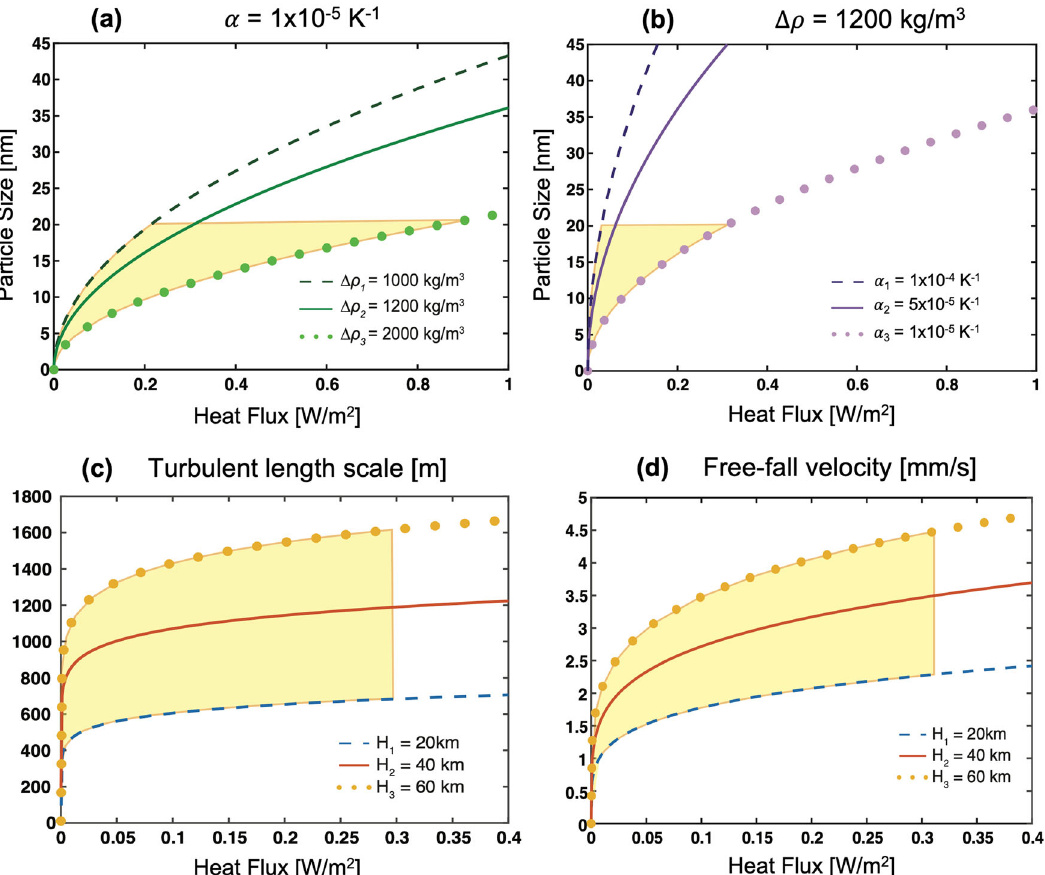
Fig. 3 Particle size, length scale, and velocity results. a Entrained particle size versus heat fl ux for three different fl uid-particle density contrasts of Δ ρ = 1000, 1200, and 2000kg m − 3 (corresponding to amorphous silica particle densities of 2000, 2200, and 3000 kg m − 3 , respectively) with a constant thermal expansion coef fi cient of α ’ 1 × 10 − 5 K − 1 . b Entrained particle size versus heat fl ux for thermal expansion coef fi cients of α ’ 1 × 10 − 5 , 5 × 10 − 5 , and 1 × 10 − 4 K − 1 with a constant density contrast of Δ ρ ¼ 1200 kg m − 3 . Yellow shaded areas represent the range of heat fl ux values that yield entrainment of particles comparable in size to those detected by Cassini and reported in ref. 10 . c Plot of turbulent length scale and d free-fall velocity versus heat fl ux for constant values of thermal expansivity ( α ¼ 1 × 10 − 5 K − 1 ) and density contrast ( Δ ρ ¼ 1200 kg m − 3 ) within the ocean. Results for three different ocean thicknesses are also shown. Yellow shaded areas represent the range of heat fl ux values found in ( a ) and ( b ) for these α and Δ ρ